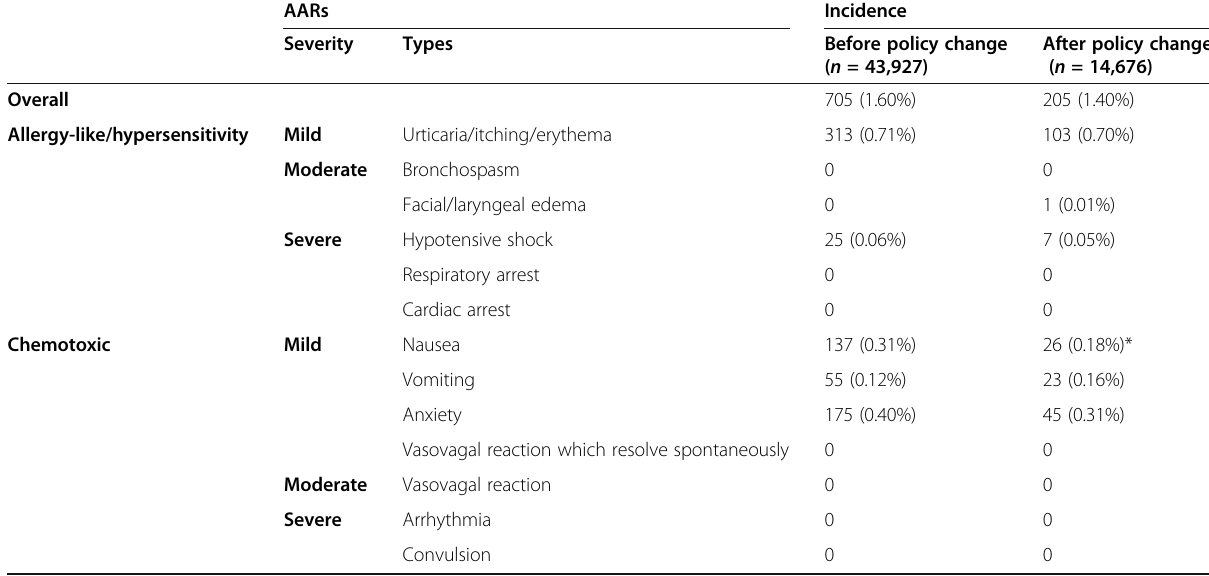
Table 2 AARs before and after the policy change AARs Incidence Severity